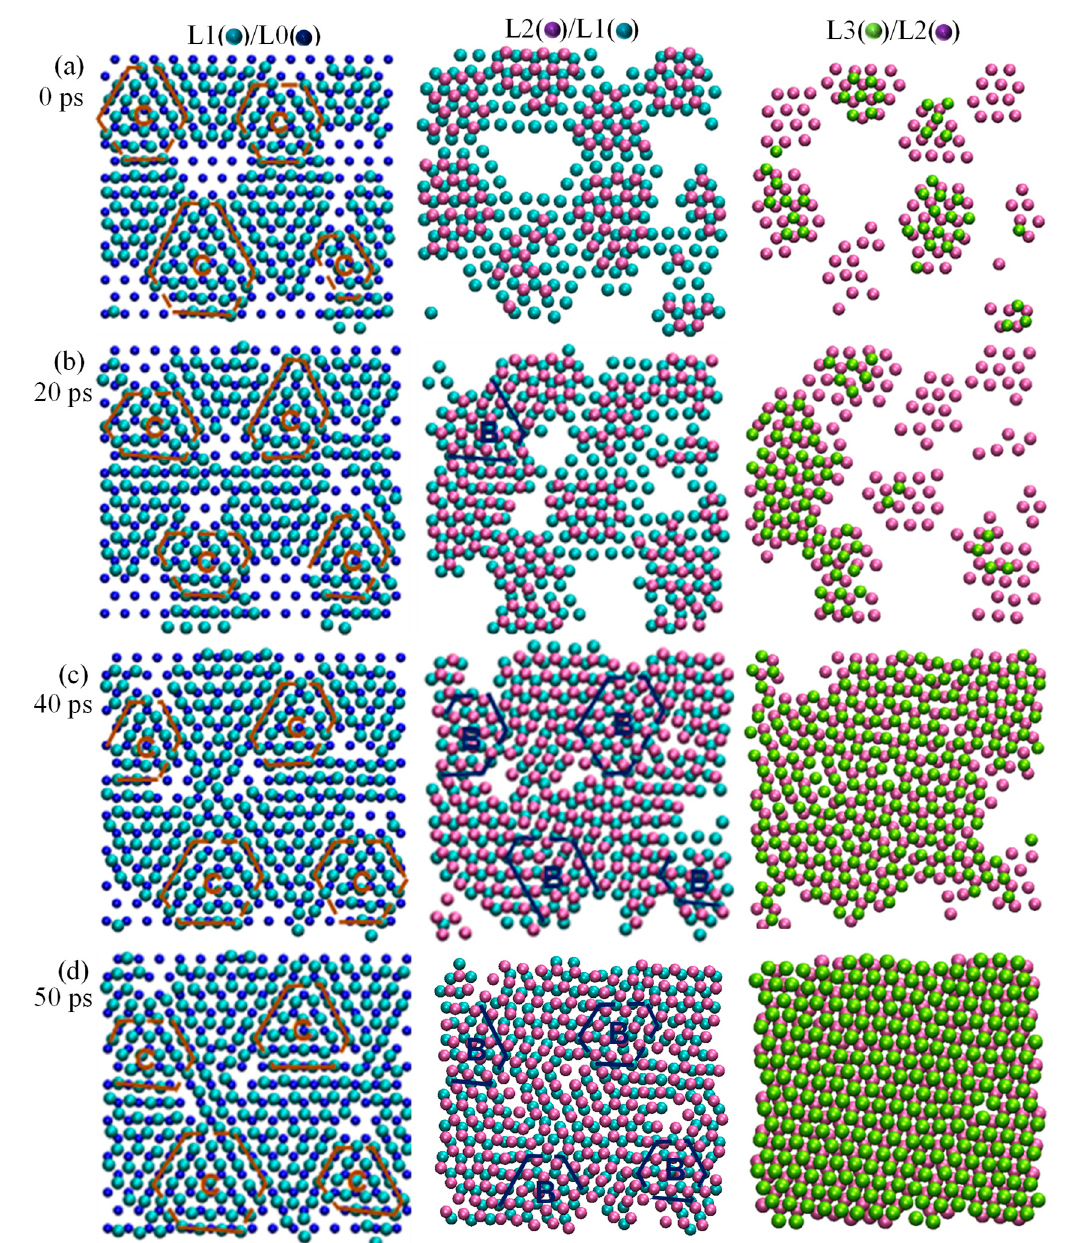
Figure 4. Evolution of atomic ordering through structural templating during nucleation. Atomic arrangements of the solid atoms at the interface as a function of time: ( a ) t = 0 ps, ( b ) 20 ps, ( c ) 40 ps, and ( d ) 50 ps during the simulation for the system with f = − 8% at T n = 760 K, where the liquid atoms have been removed from the snapshot. “C” and “B” mark the stacking fault that is surrounded by partial dislocations (the solid lines) in L1 and L2, respectively. Starting from the precursor created by prenucleation, nucleation proceeds layer-by-layer through structural templating: L1 accommodates lattice misfit via a partial edge dislocation network; L2 twists an angle of θ via a partial edge dislocation network to reduce lattice distortion; L3 is a nearly perfect plane of the solid that templates further growth.